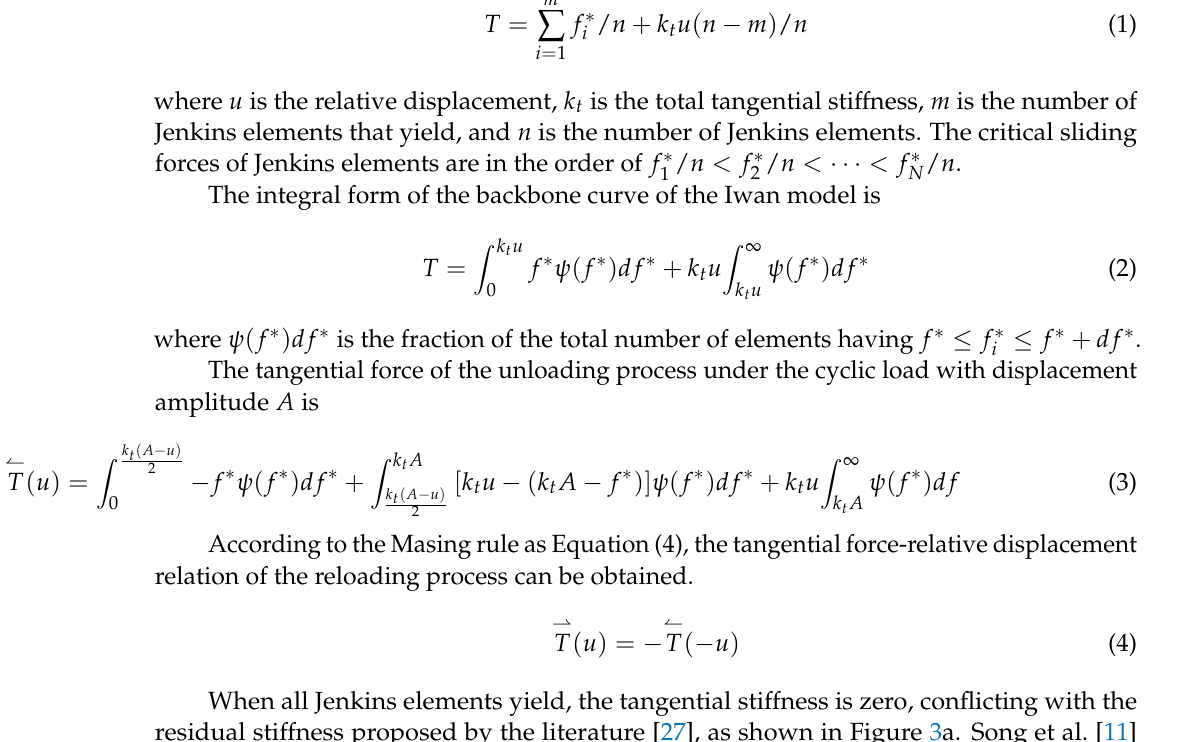
/ n < f ∗ / n < · · · < f ∗ / n . N 2 1